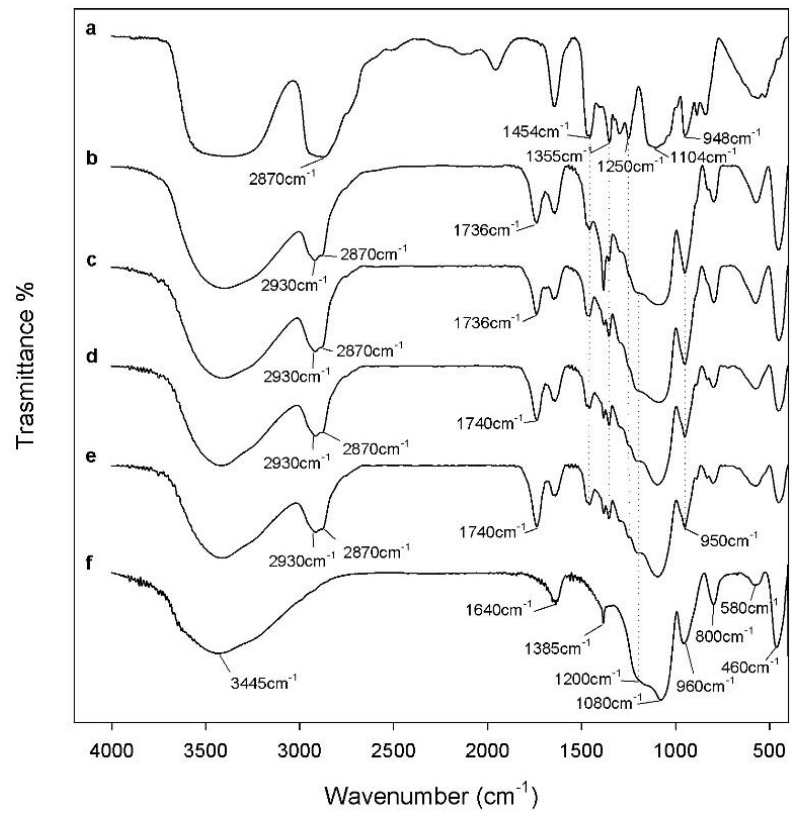
Figure 2. Representative Fourier transform infrared (FTIR) spectra of: ( a ) pure polyethylene glycol (PEG); ( b ) SiO 2 /PEG 50 wt % /chlorogenic acid (CGA) 5 wt % ; ( c ) SiO 2 /PEG 50 wt % /CGA 10 wt % ; ( d ) SiO 2 /PEG 50 wt % /CGA 15 wt % ; ( e ) SiO 2 /PEG 50 wt % /CGA 20 wt % ; ( f ) pure SiO 2 .